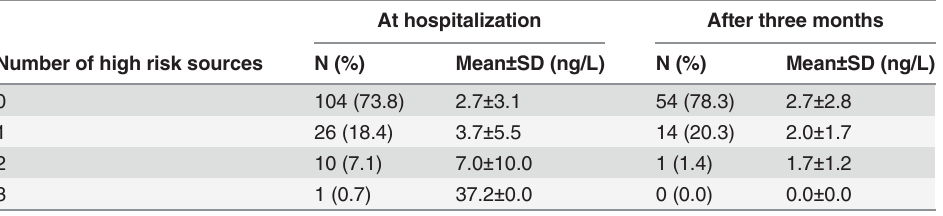
Table 3. Interleukin-10 Plasma Concentration in Different Stroke Patient Categories Defined by the Total Number of the European Association of Echocardiography High Risk Sources. At